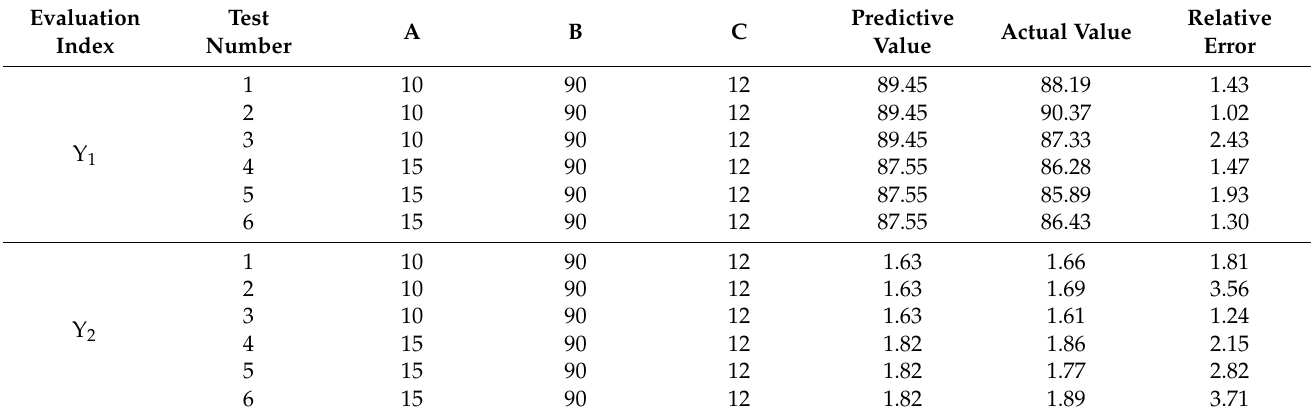
Figure 17. Test results of different control groups. Table 7. Validation test